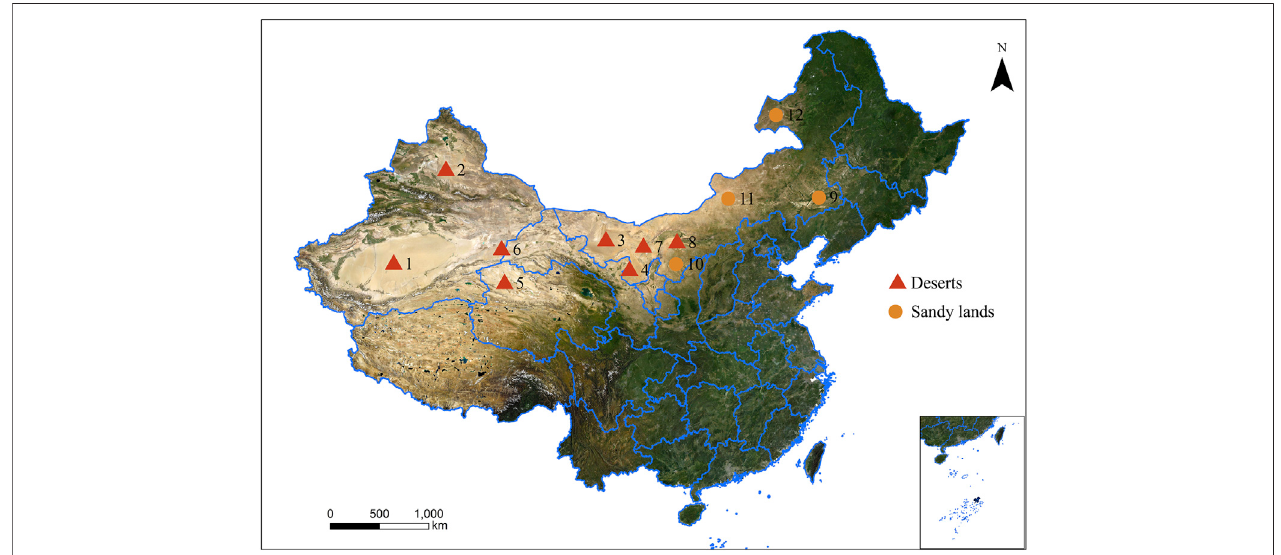
FIGURE 1 | Geographic distribution of the main deserts (including eight deserts and four so-called sandy lands) in Northern China which were selected as search termsinthebibliometricanalysis.1:theTaklimakanDesert;2:theGurbantunggutDesert;3:theBadainJaranDesert;4:theTenggerDesert;5:theQaidamDesert;6:the